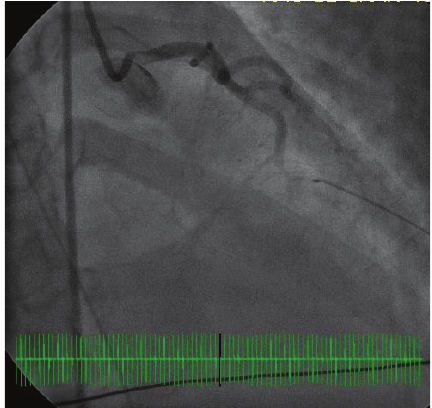
Figure 3: Left heart catheterization representing 99% occlusion of mid-distal LAD.